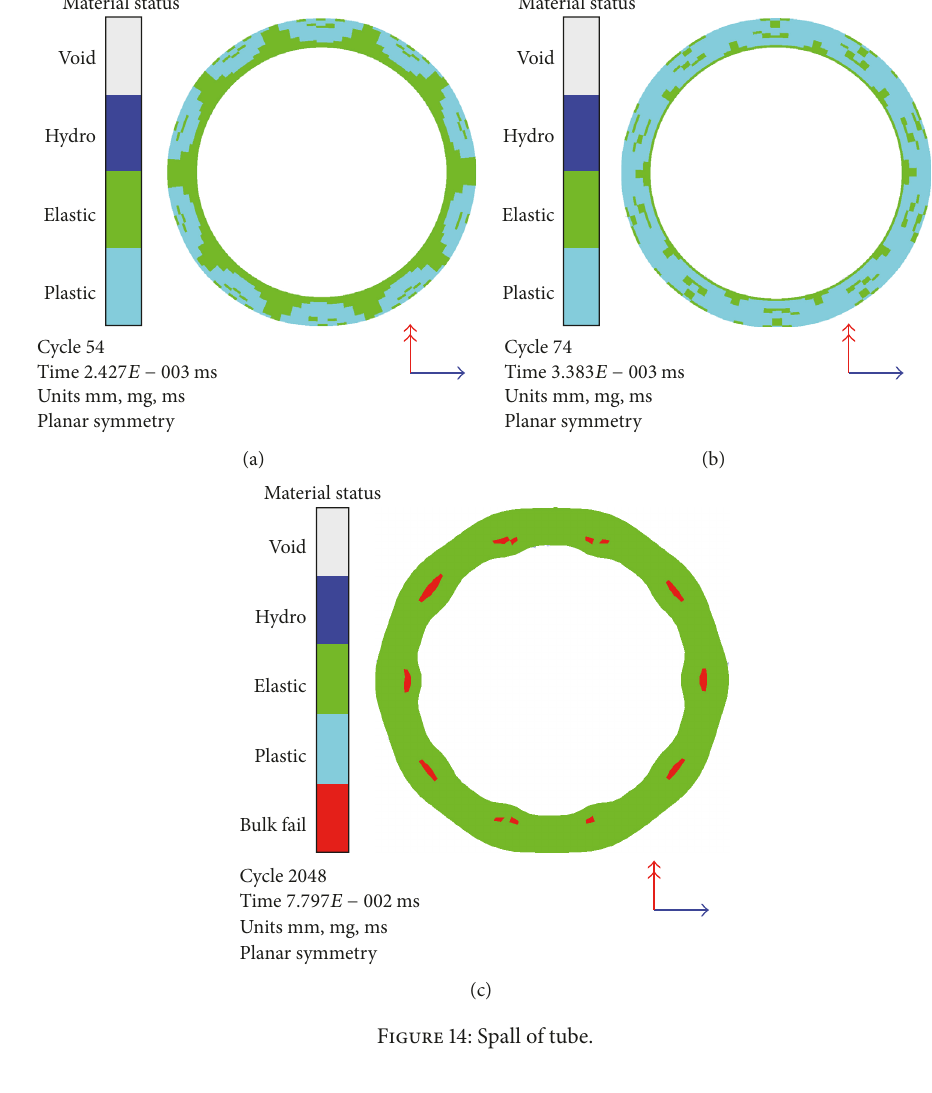
Figure 14: Spall of tube.